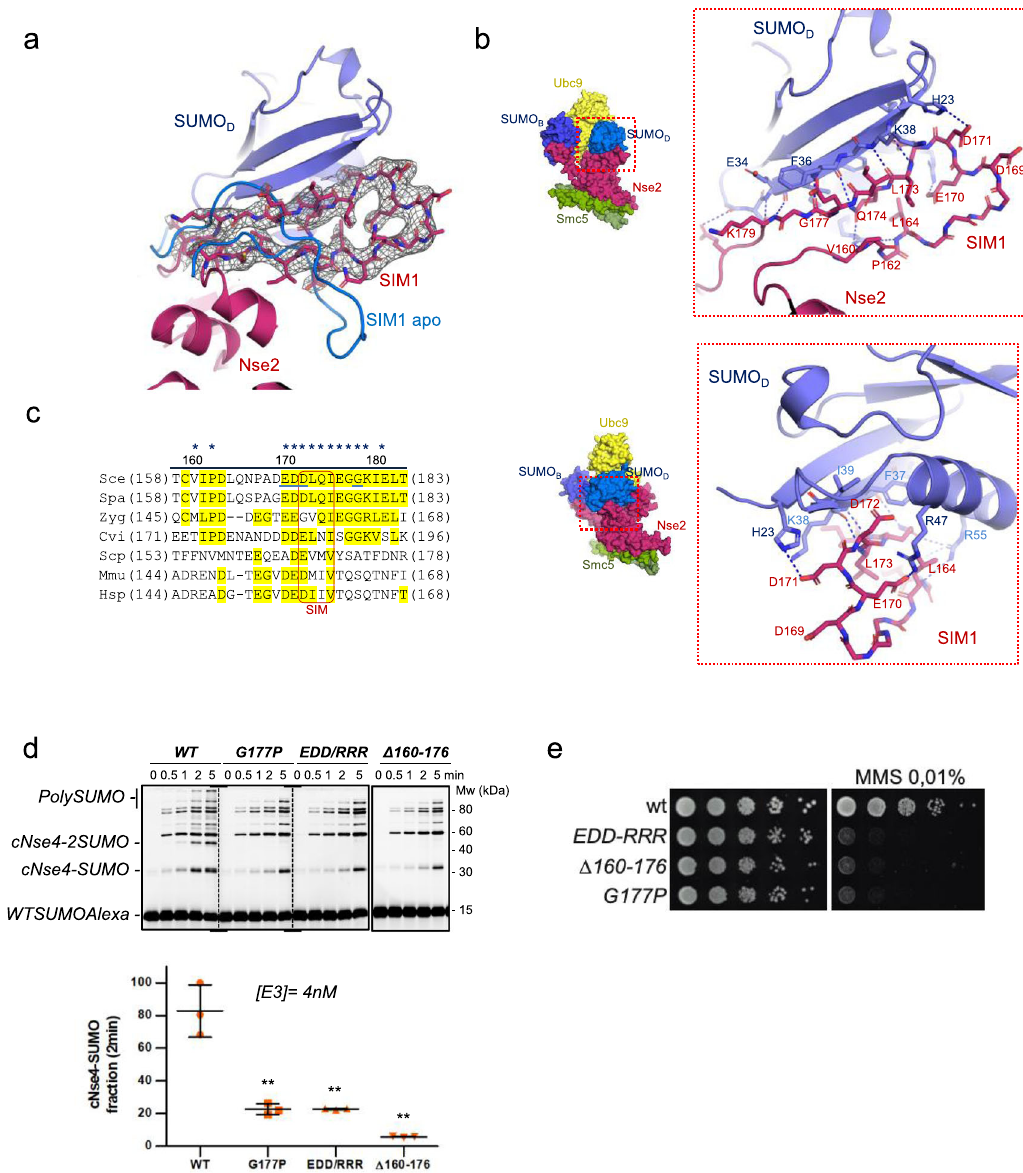
Fig. 6 Conformational change of Loop-SIM1 upon binding to the E2-SUMO D donor. a Structure and electron density maps of Loop SIM1. b Cartoon representation of the complex between Loop SIM1 Nse2 (V160 to K179) and SUMO D . c Multiple alignment of SIM1 sequences from Saccharomyces cerevisiae , S. eubayanus , S. paradoxus , Zygos. parabailli , Schizos. pombe , Mus musculus and Homo sapiens (poor conservation except for the acidic region). d Multiple-turnover SUMOylation reactions of yeast Nse2-Arm/Smc5 complex (wild type and mutants) using cNse4 at 30 °C. Error bars showing that point mutations or deletion of SIM2 reduce E3 activity. Data values represent the mean ±SD, n = 3 technical replicates. Signi fi cance was measured by a two- tailed unpaired t-test relative to wild-type. All data were analyzed with a 95% con fi dence interval. ** P < 0.005. Exact P values from the left to right: 0.0032, 0.0029, 0.0011. Source data are provided as a Source Data fi le. e Growth test analysis of wild type, nse2-EDD-RRR , nse2- Δ 160-176 and nse2-G177P cells; 10- fold serial dilutions of liquid cultures were spotted in YPD in the presence or not of MMS 0.01% and incubated at 30 °C for 60